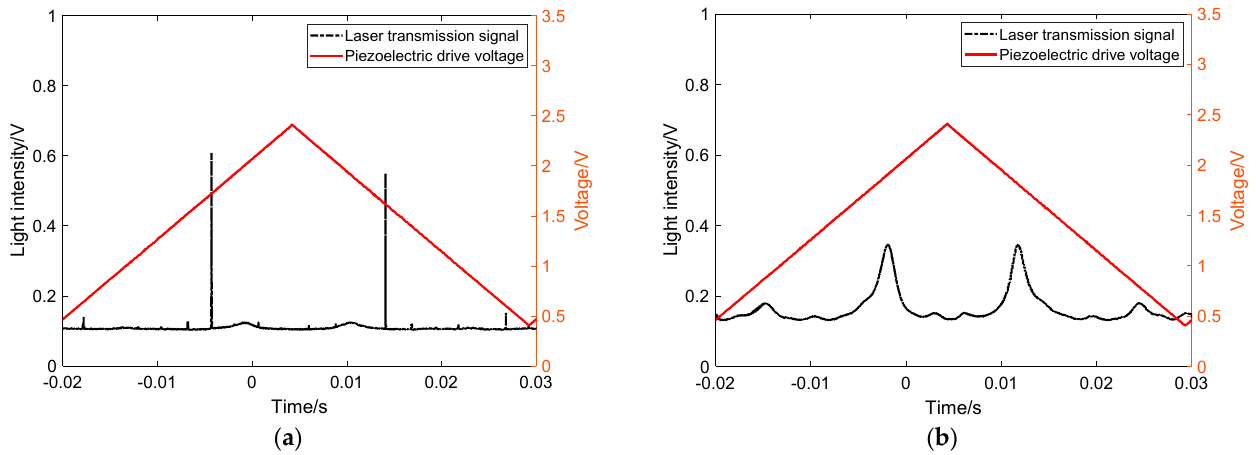
Figure 4. Resonant light signal by turning the line polarizer between mirror M3 and detector PDA1. ( a ) The signal of S-Polarized direction; ( b ) the signal of P-Polarized direction.